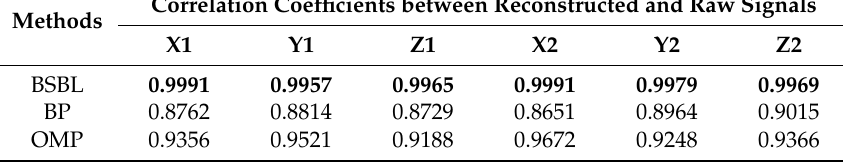
Table 3. Signal recovery results of BSBL, BP and OMP algorithms.